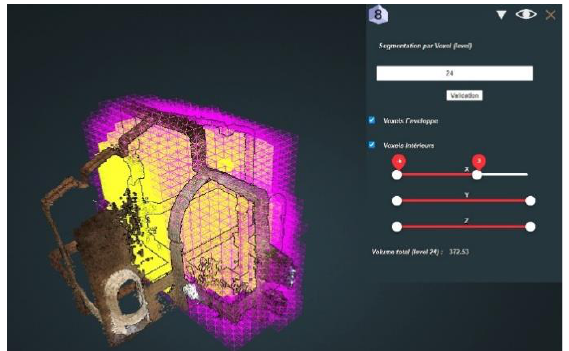
Figure 8 : This representation was obtained by creating a bounding box around the whole cloud, then by cutting it on the 3 axes, in a predetermined number of cuts, here 24, then by eliminating all the voxels which are outside of the point cloud. A distinction is made between the surface voxels and those of the interior. On this example is shown the manipulation of this voxel division via a menu on the X, Y and Z axes (right part, submenu). In purple surface voxels, in yellow, the interior voxels. The current user manipulation is done on the X axis.